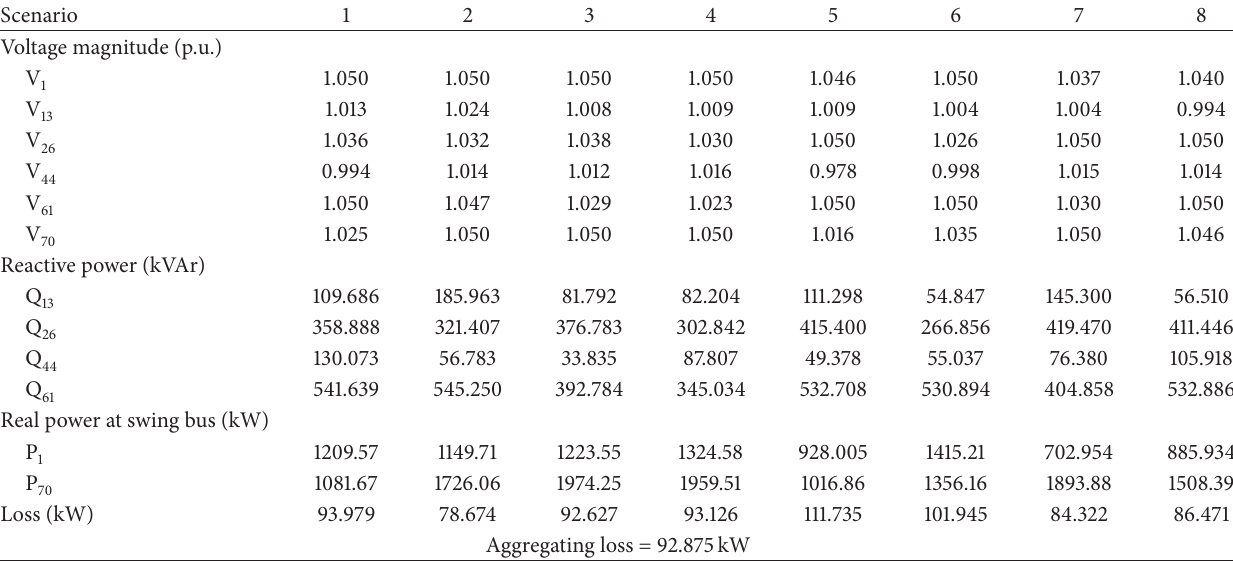
Table 5: Optimal results after the feeder reconfiguration using the proposed